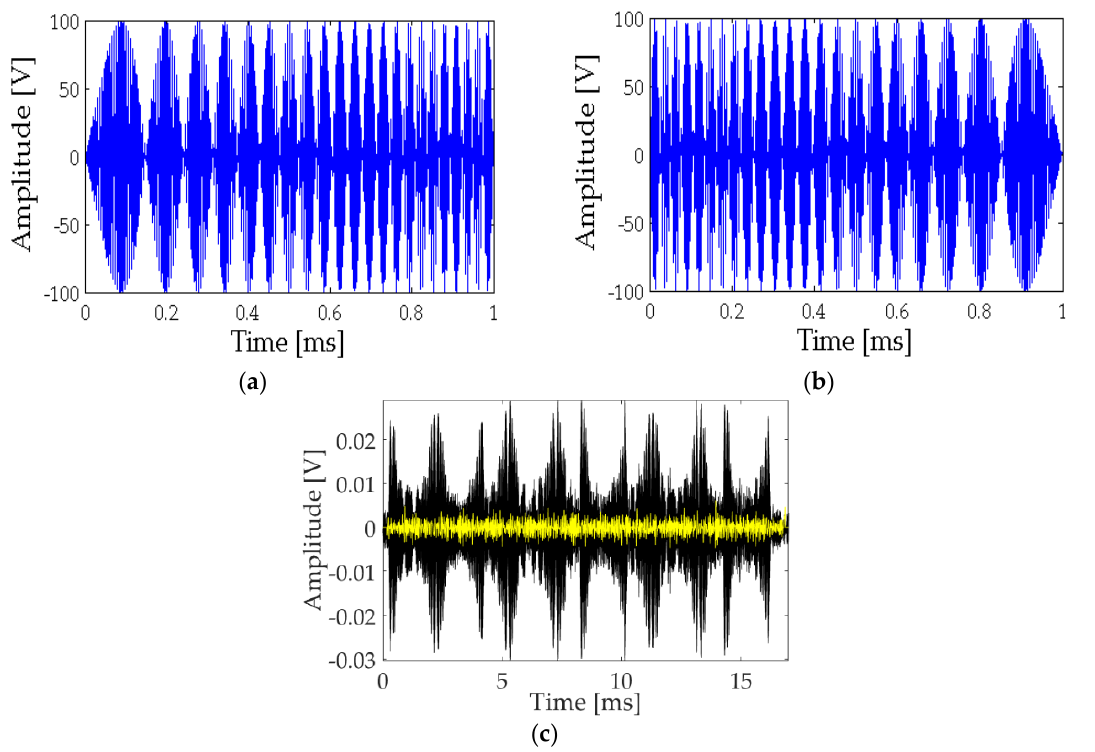
Figure 3. Signal used in the analysis. ( a ) Bit 1: Upwards sine sweep signal; ( b ) Bit 0: Downwards sine sweep signal; ( c ) 16-bit received signal (black) and filtered at low frequencies (multiplied by a factor of 20, yellow).